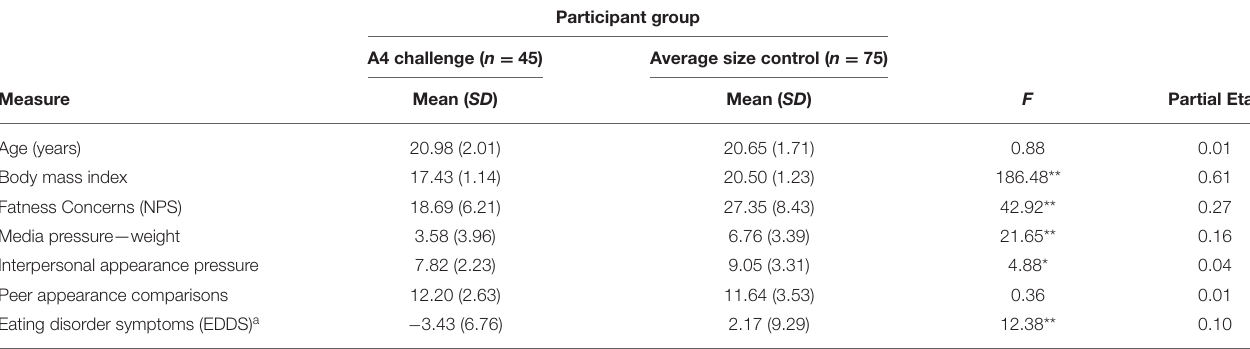
TABLE 3 | Body image experience differences between women who pass the A4 challenge and average weight women ( N =